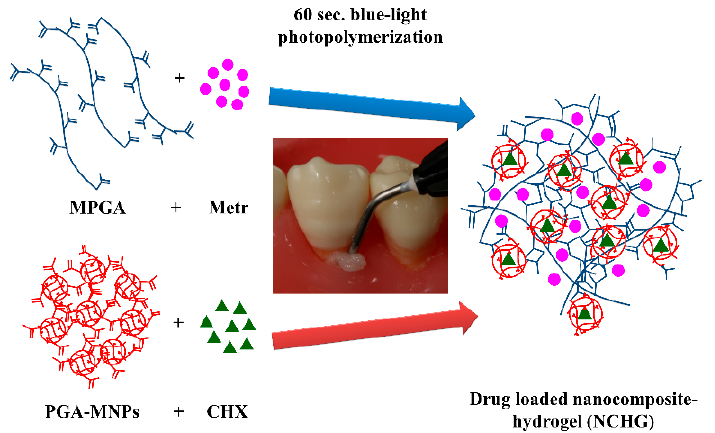
Figure 4. Schematic way of the preparation of MPGA/PGA-MNPs nanocomposite hydrogels.